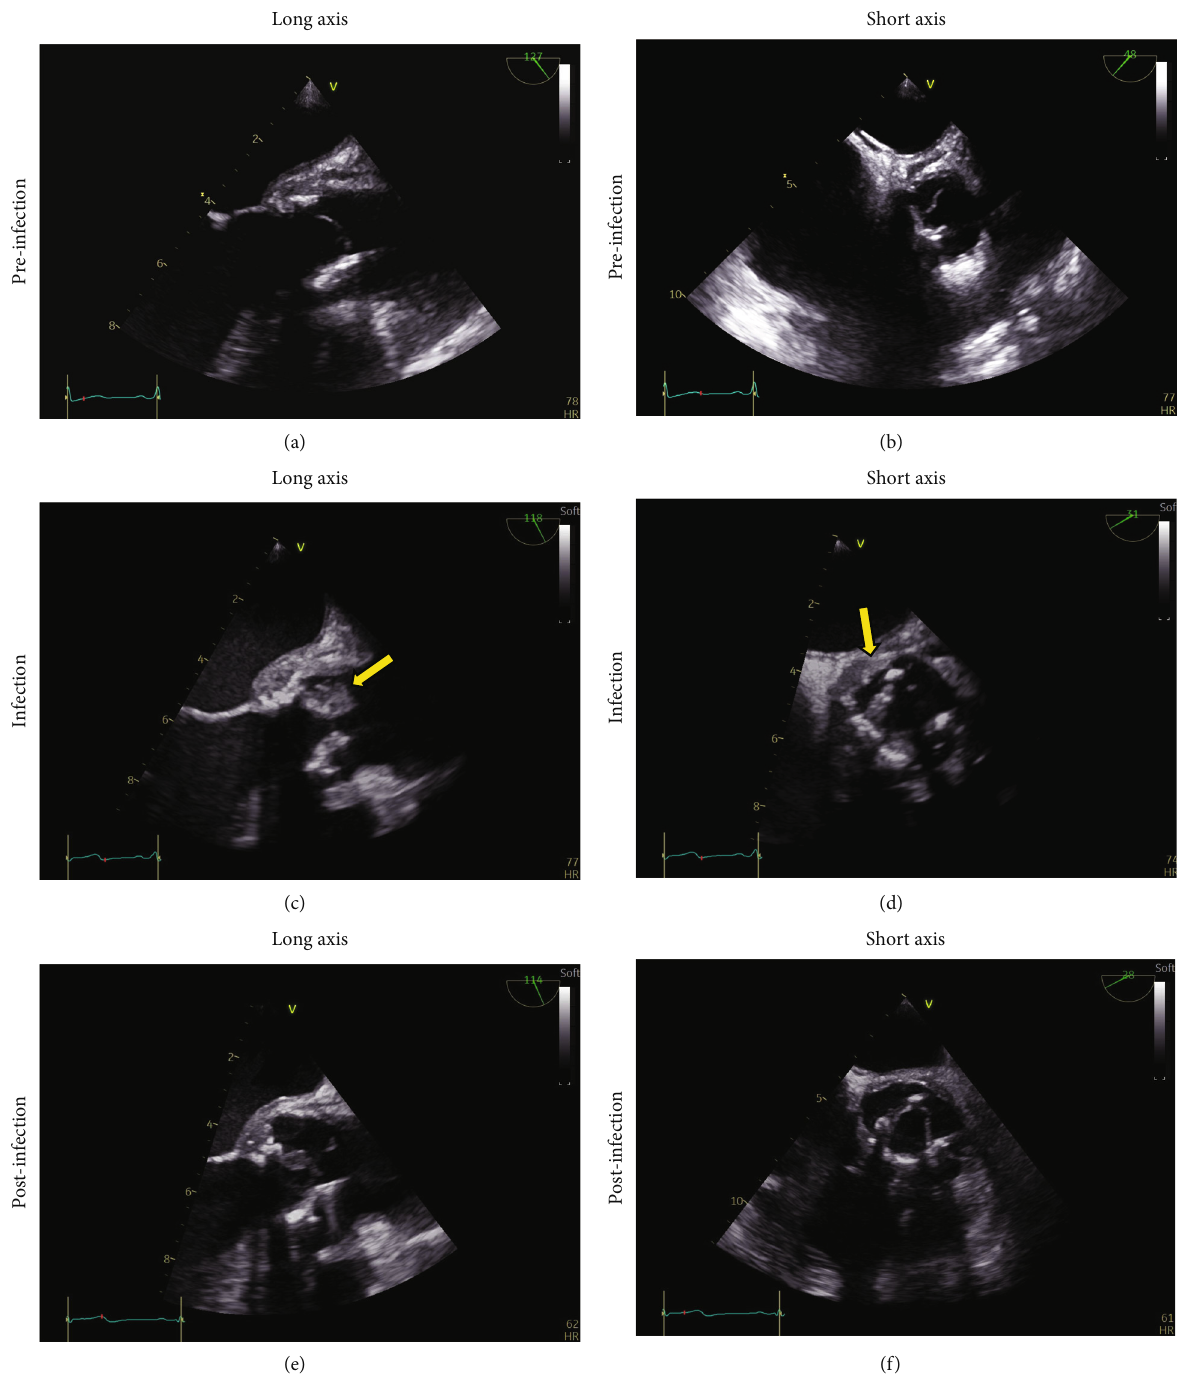
Figure 3: Transesophageal echocardiography images of the biological aortic valve prosthesis seen before (a and b), during (c and d), and after (e and f) active infection. Images are shown in long axis (a, c, and e) and short axis (b, d, and f). Yellow arrows point to the excrescence on the non-coronary cusp of the biological aortic valve